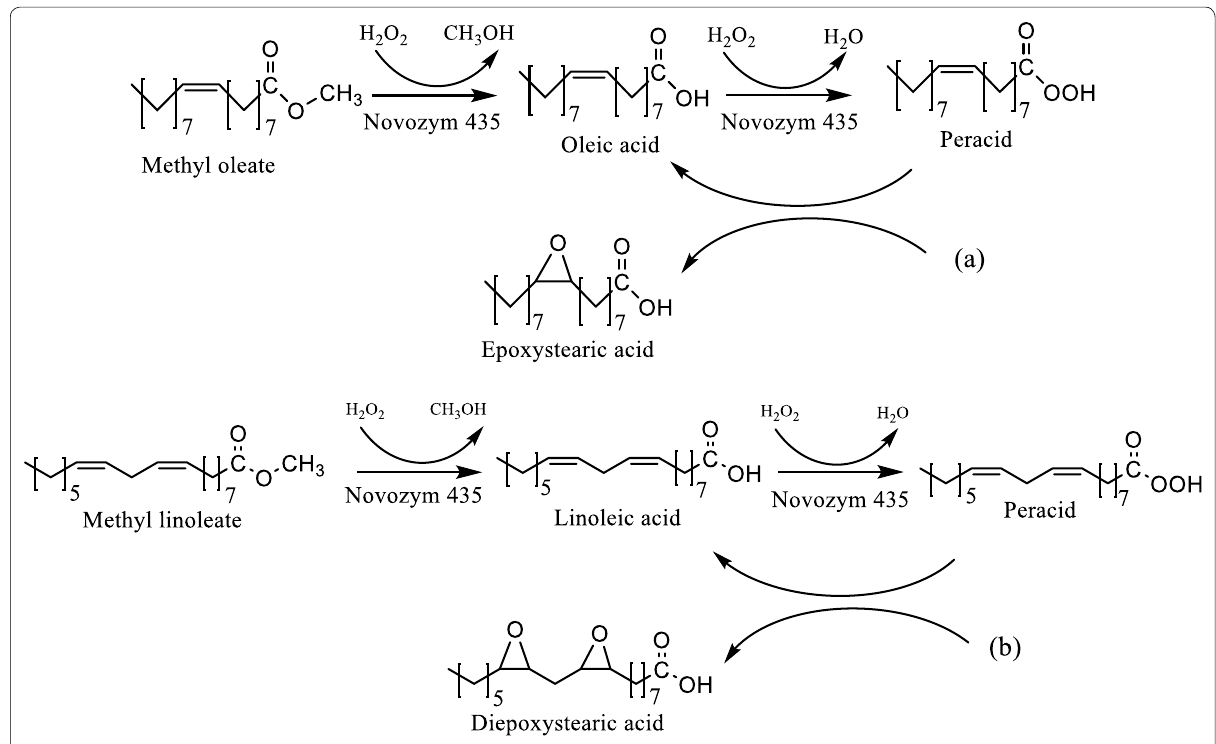
Fig. 5 Reaction mechanism of FAMEs hydrolysis to yield